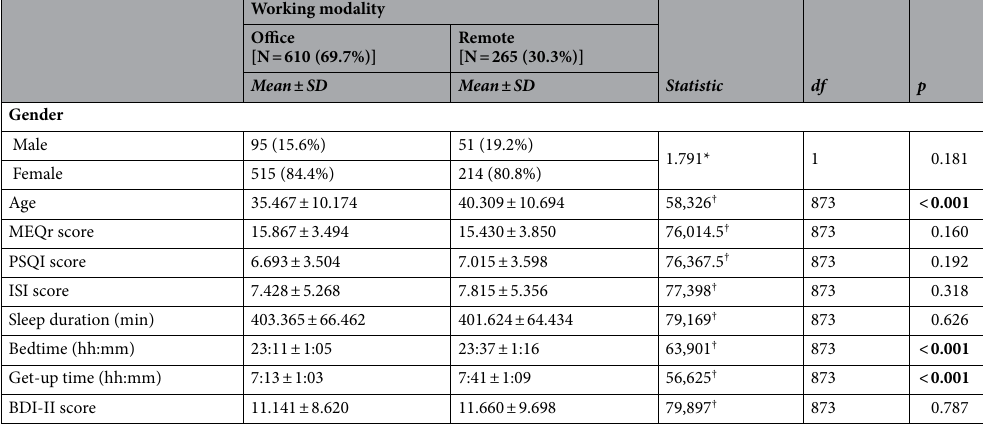
Table 1. Characteristics of participants divided by working modality (office, remote). Results of the comparisons between the working modality groups are also shown. *Chi-square, † Mann–Whitney U. SD standard deviation, df degrees of freedom, PSQI Pittsburgh sleep quality index, ISI insomnia severity index, MEQr morningness-eveningness questionnaire-reduced version, BDI-II beck depression inventory-second edition. Significant values are in